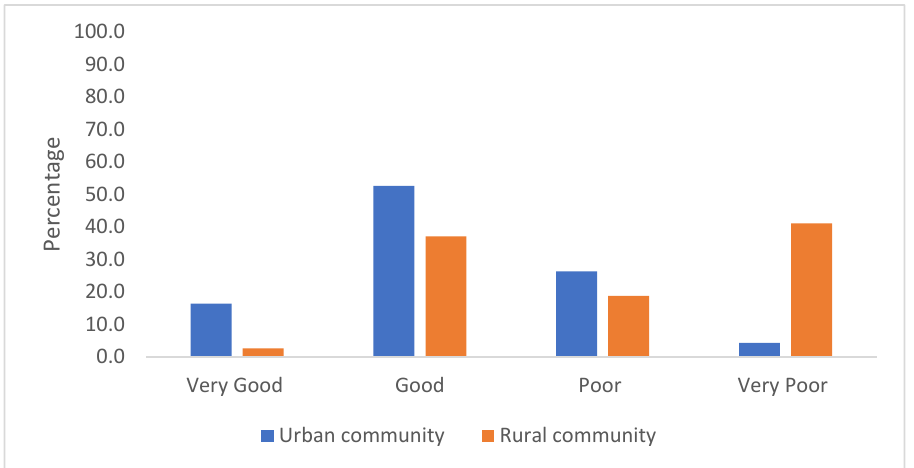
Figure 1. Respondents’ perceptions of their knowledge regarding antibiotics.